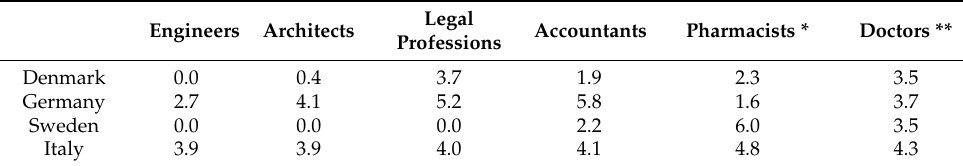
Table 1. The index of entry-market regulations by country and profession